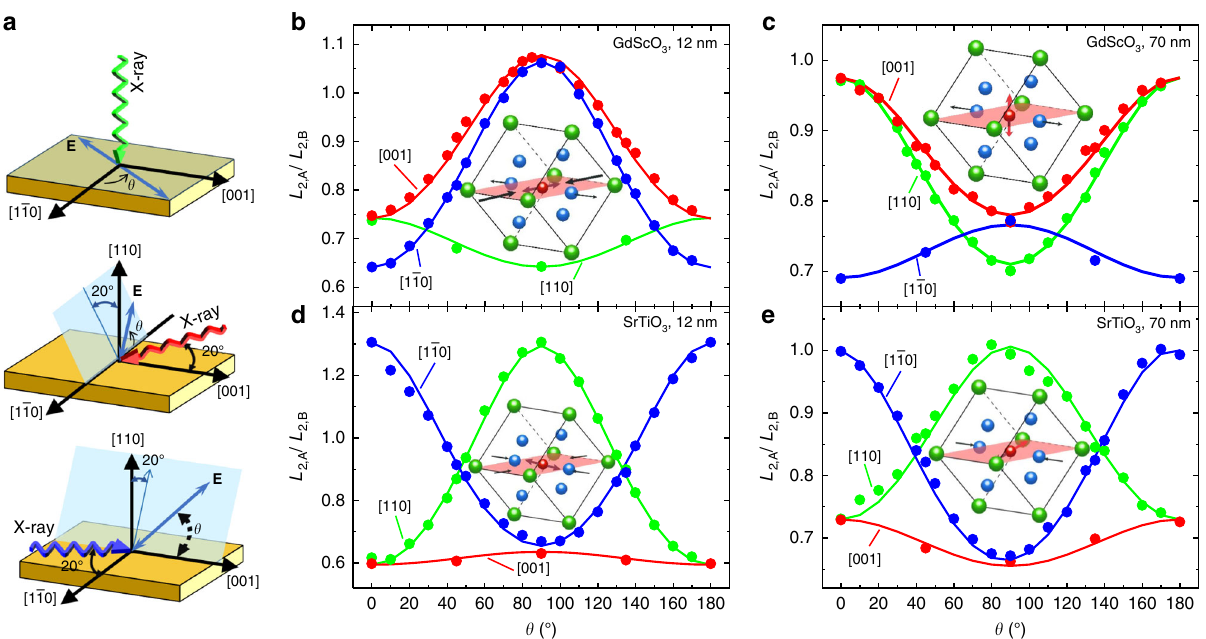
Fig. 2 Angle- and polarization-dependent X-ray absorption spectroscopy. a Schematics of the measurement geometries where θ is the angle between the polarization vector E of the incoming X-rays (blue arrows) and the principal crystallographic axes as labeled. Experimental (solid points) and calculated (lines) show the polarization dependence of the Fe- L 2 -peak ratio as a function of θ for incident X-rays along the [110] (green lines), [001] (red lines), and (cid:1) (cid:3) 110 (blue lines) of b 12 nm and c 70 nm thick fi lms on GdScO 3 (010) O , and d 12 nm and e 70 nm thick fi lms on SrTiO 3 (110). Insets of ( b – e ) show the schematics of the strain states and the orientation of L (red